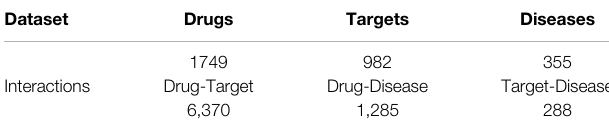
TABLE 2 | Statistics of the Benchmark standard dataset used in this